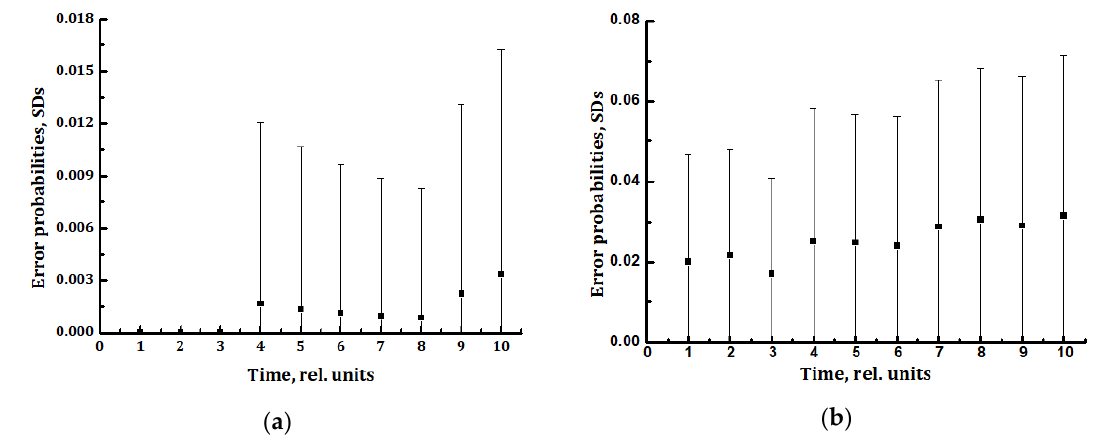
Figure 11. Examples of the estimated probabilities of error and SD for underwater communication experiments beneath the ice surface using the scheme shown in Figure 10: ( a ) with α 2 = 30 ◦ ; ( b ) α 1 = 30 ◦ .